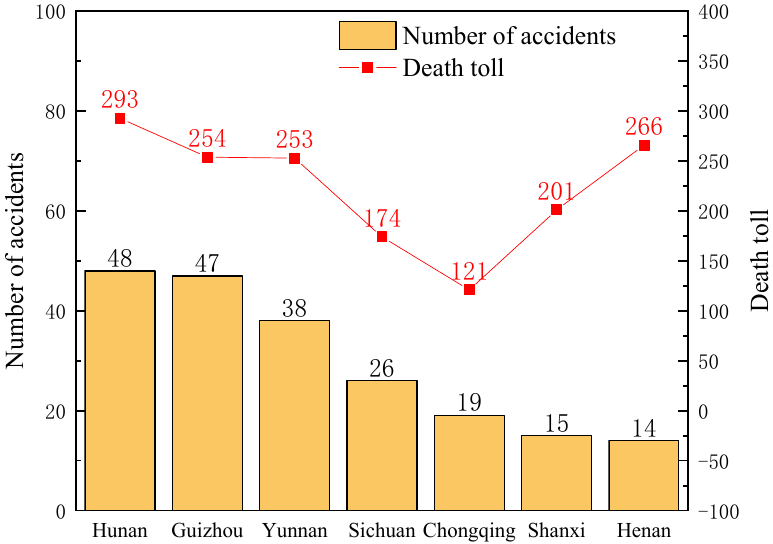
Figure 6. Statistics of gas accidents in different provinces from 2008 to 2013.